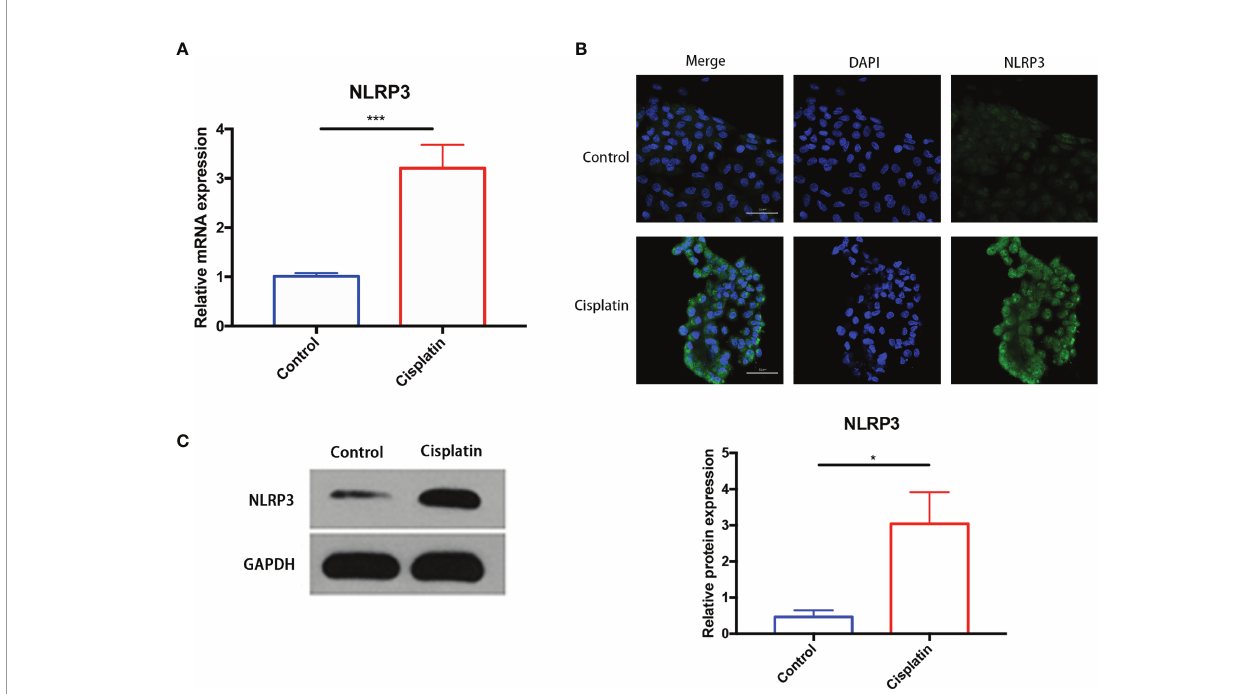
FIGURE 2 | Cisplatin induced an increased expression of NLRP3 in MCs at both the mRNA level and the protein level. (A) The expression difference of NLRP3 mRNA in MCs between the control and the cisplatin group (5 m mol/l cisplatin for 24 h). (B, C) The increased expression of NLRP3 protein in the cisplatin group compared with the control detected by immuno fl uorescence (B) and Western blotting (C) . Green fl uorescence indicates FITC-labeled NLRP3 protein, and blue fl uorescence indicates DAPI-labeled nuclei. Scale bars: 50 µm. Representative results of at least three repeated experiments are shown. *p < 0.05, ***p <